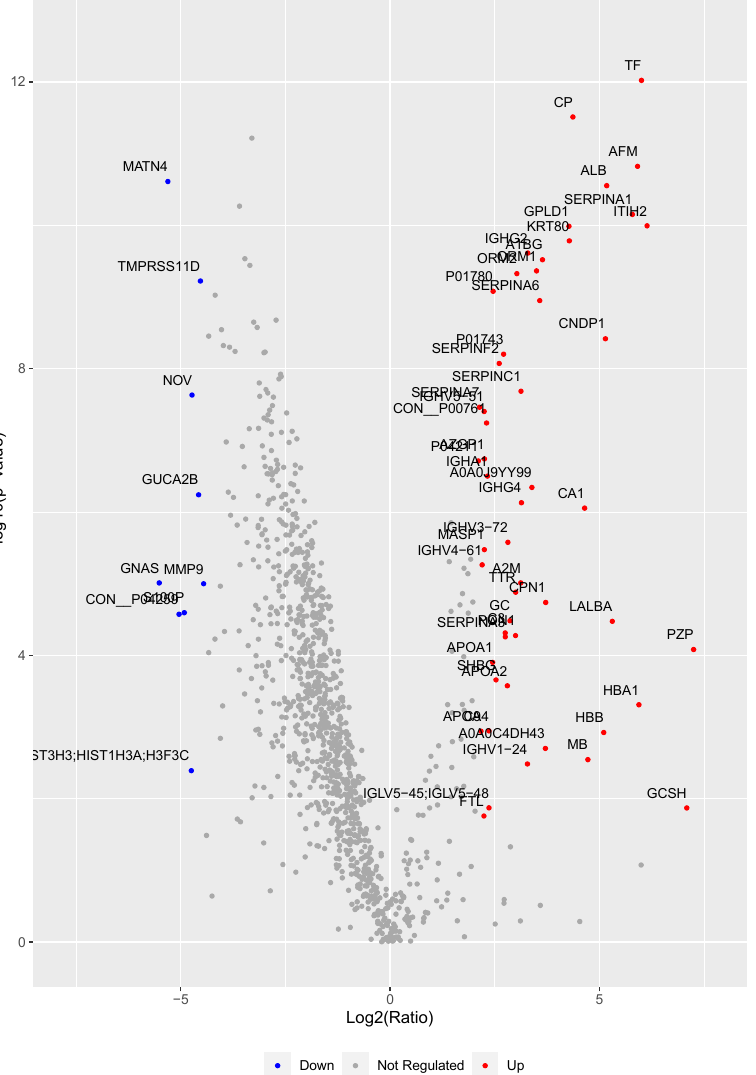
Figure 3. Volcano plot of the 1108 proteins quantified in the proteomic analysis. The x-axis corresponds to the fold change (Log2 of PE/control protein intensity ratio), the y-axis corresponds to the statistical value ( − Log10 (p- value)). Significantly regulated proteins are displayed in red (upregulated) or in blue (downregulated); non-significantly regulated proteins are displayed in grey.